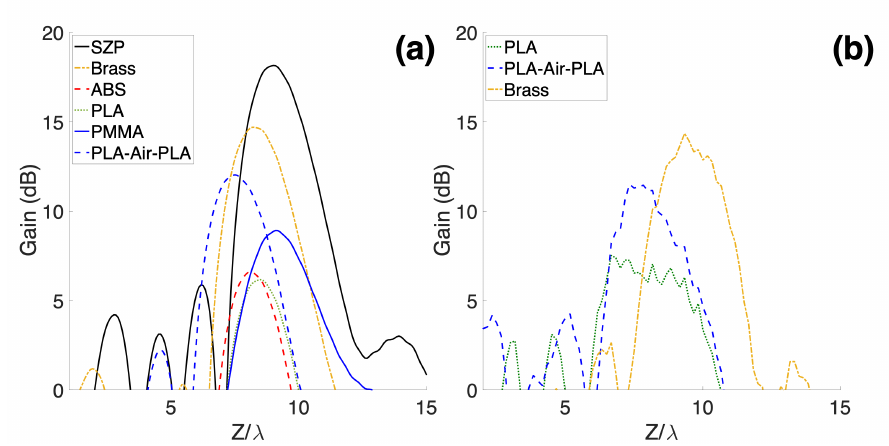
Figure 5. Intensity gain longitudinal cuts for ( a ) FEM results and ( b ) experimental results.